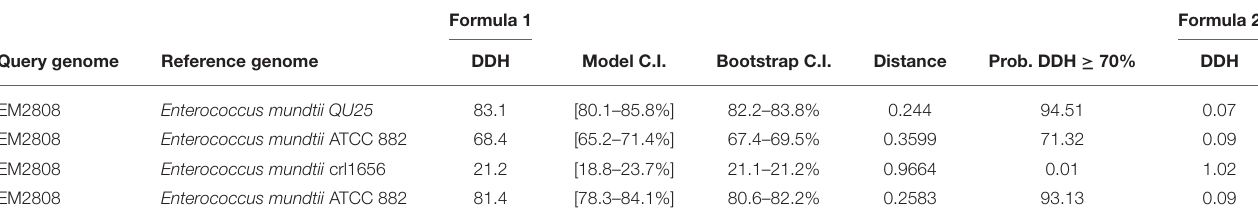
TABLE 3 | GGDC calculator results DNA-DNA hybridization (DDH), Bootstrap C.I (C.I Confidence Interval).